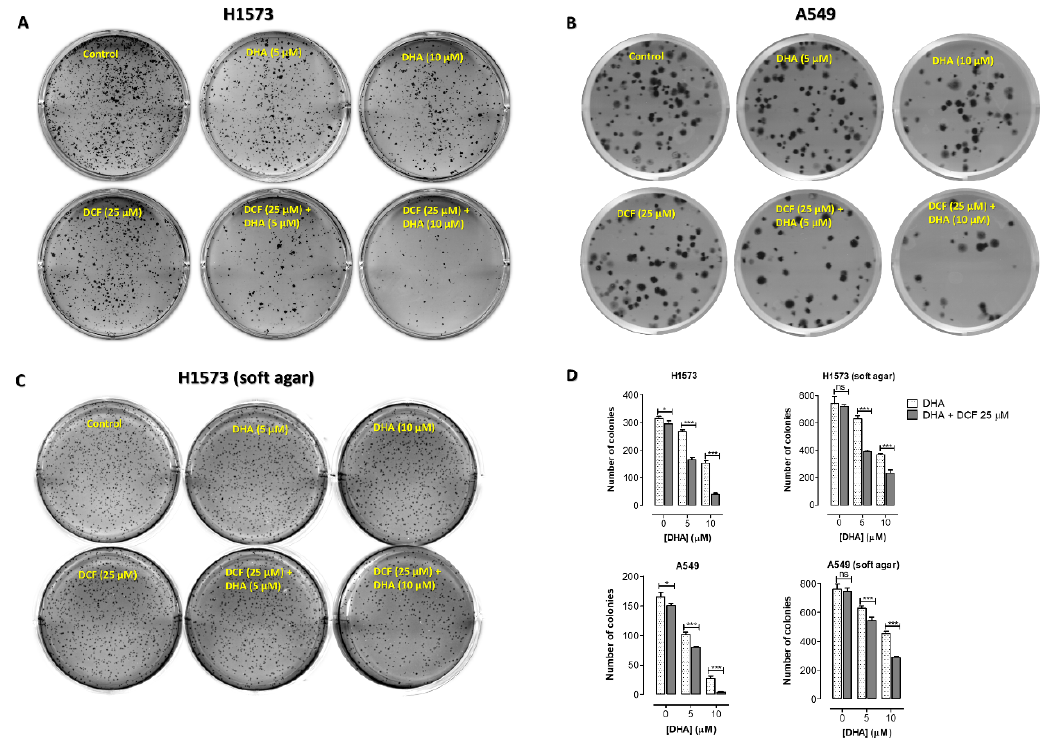
Figure 4. Clonogenic cell survival and anchorage-independent cell growth of NCI-H1573 and A549 cells in response to co-treatment with DHA and diclofenac (DCF). Representative images of cells treated with DHA and diclofenac are shown. ( A,B ) For clonogenic cell survival assays, cultured cells were pre-treated with DHA (0–10 µ M) and DCF (25 µ M) for 48 h. Cells were then trypsinized, washed, counted and incubated for a further 10–14 days at 37 °C after which the clonogenic survival was determined. ( C ) For the anchorage independent growth (soft agar) assay, counted cells were plated in soft agar and treated weekly as described in the methods for 21 days. ( D ) The number of colonies formed were counted, and the results are expressed as the means ( ± SEM, n = 4) relative to the DHA alone treatments. Significance (* p < 0.05; *** p < 0.001) was determined by Student’s t -test.